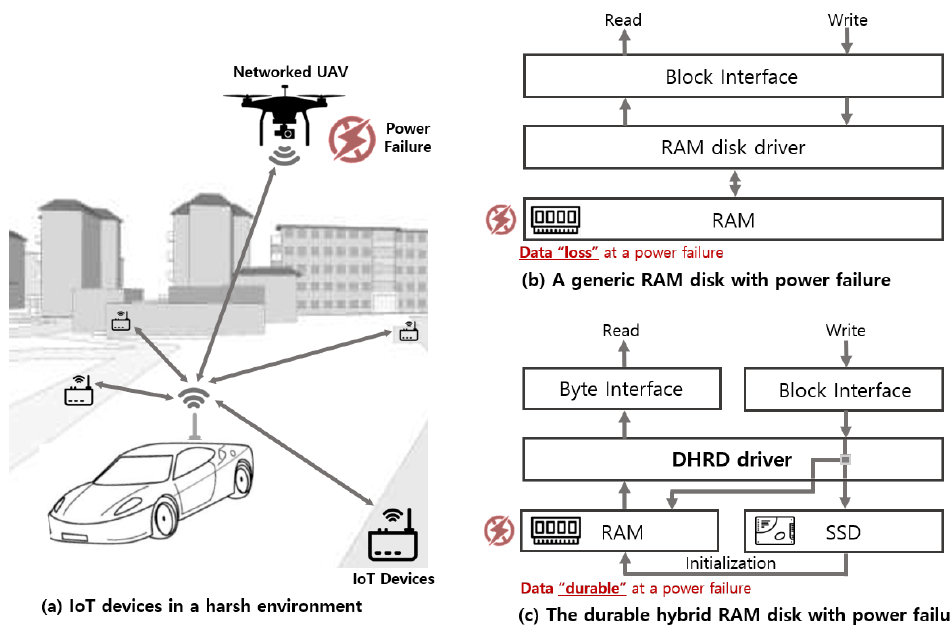
Figure 1. Software stack for the durable hybrid RAM disk (DHRD) with direct byte read